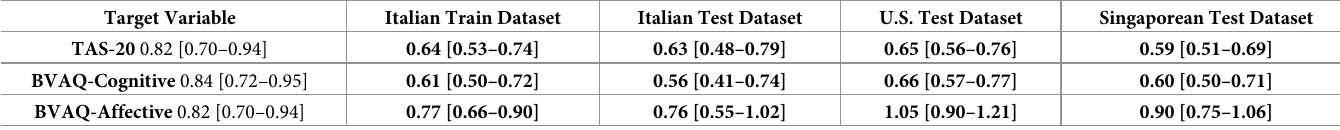
Table 4. Mean absolute error (MAE) with [90% confidence intervals] of the three ML models estimating the alexithymia scores (TAS-20; BVAQ-Cognitive; BVA- Q-Affective) on the training subset (Italian Train Dataset) and on the three test subsets: The Italian Test Dataset, the U.S. Test Dataset and the Singaporean Test Dataset.